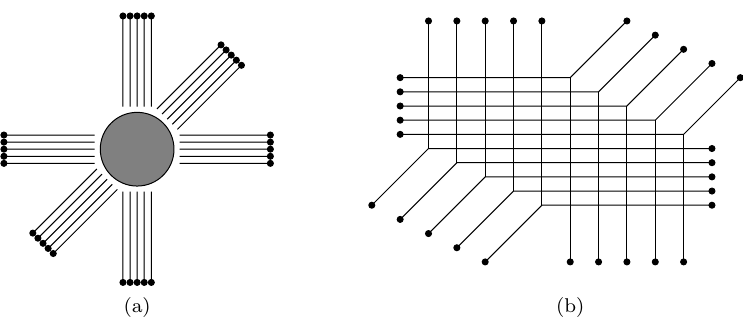
Figure 7. Brane web for the (cid:30) + N theory with N = 5 on the left hand side, and a deformation to a quiver theory on the